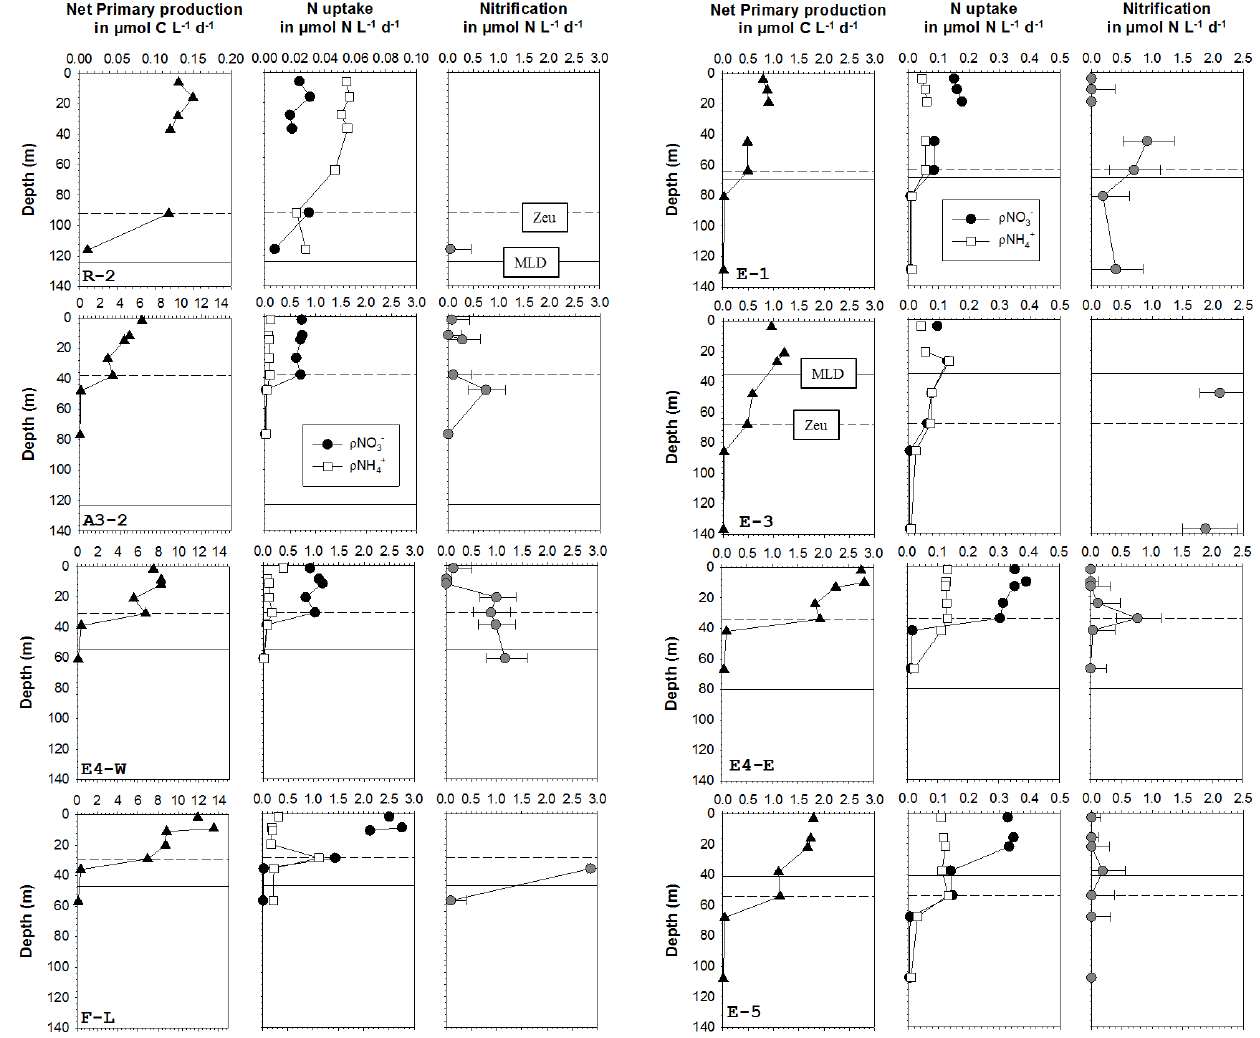
Figure 4. Vertical distribution of net primary production (NPP, left column), N uptake (middle column), and nitrification (right column; error bar corresponding to the 5 and 95% percentiles) rates between stations (rows). Note that there is a change of scale between reference R-2 site, high productivity sites (A3-2, F-L, E4-W), and meander sites (E1, E3, E4-E, E5). The dashed line represents the euphotic layer depth (Zeu = 1% PAR attenuation) and the full line represents the mixed layer